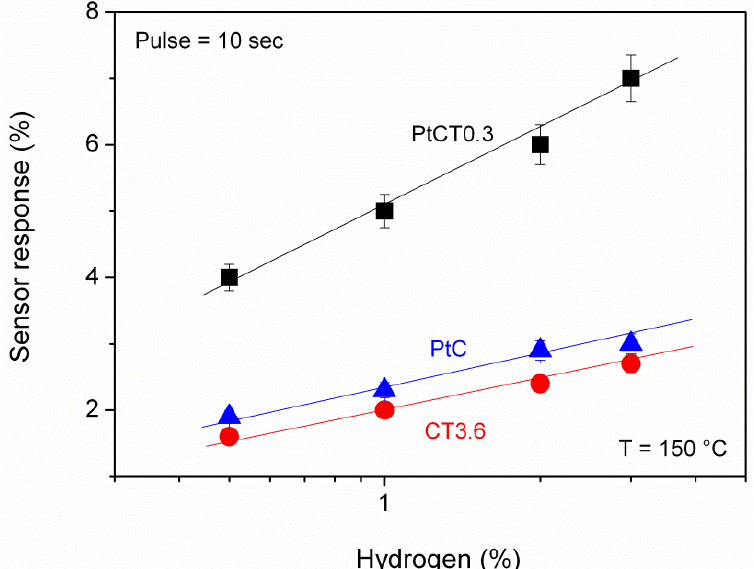
Figure 8. Calibration curves of different composite